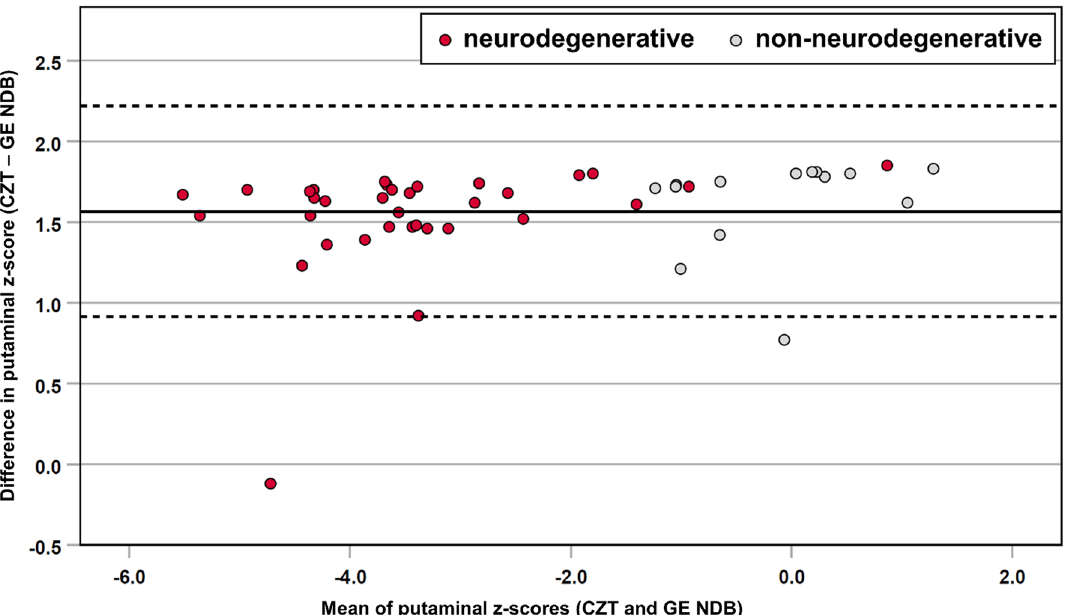
Fig. 3 Bland–Altman plot for putaminal z-scores using the CZT NDB and GE NDB, respectively. Subjects visually rated as neurodegenerative PS are indicated by red dots, subjects visually rated as non-neurodegenerative PS by gray dots